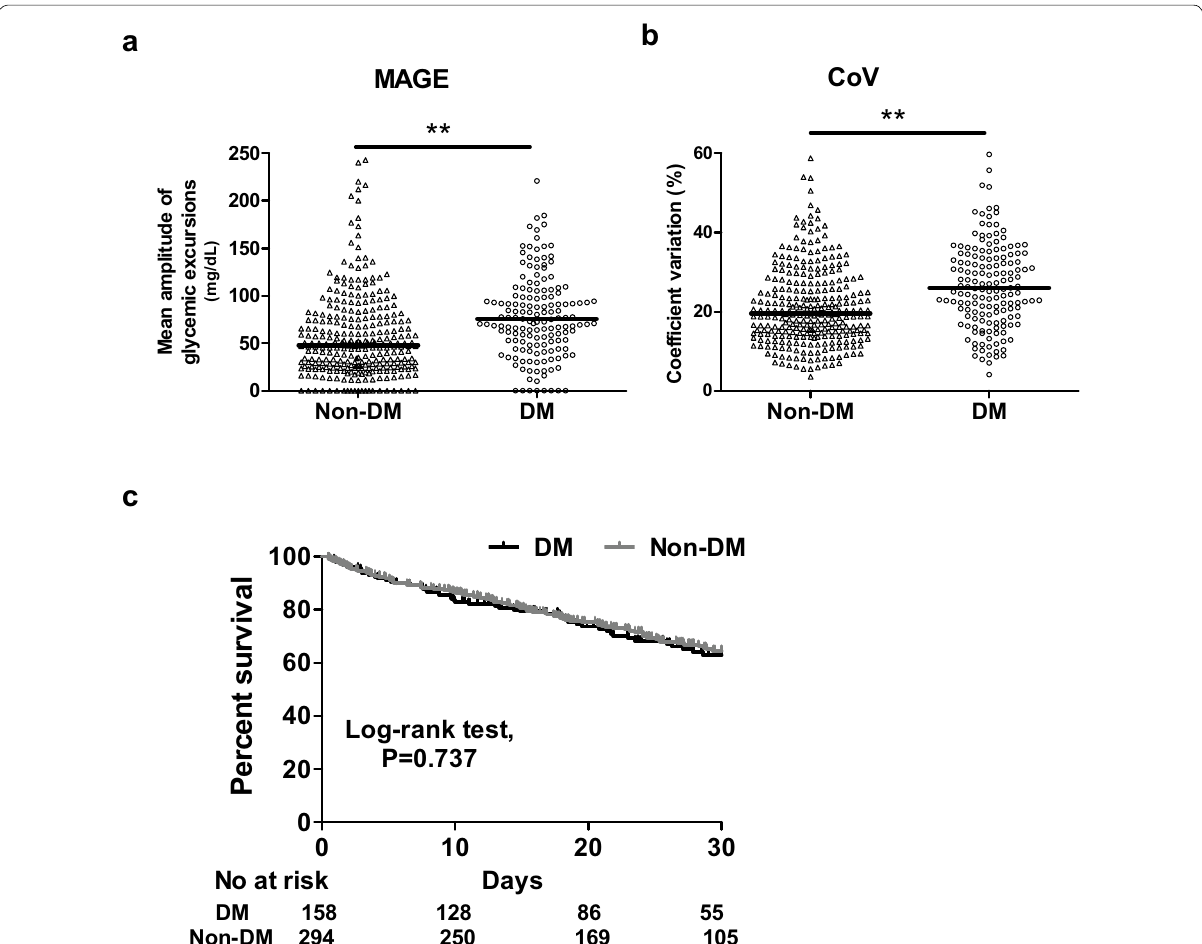
Fig. 4 Individual glycemic variability ( a , MAGE; b , CoV) in septic patients without and with DM. (C) Kaplan–Meier survival curves categorized by DM. ** p <